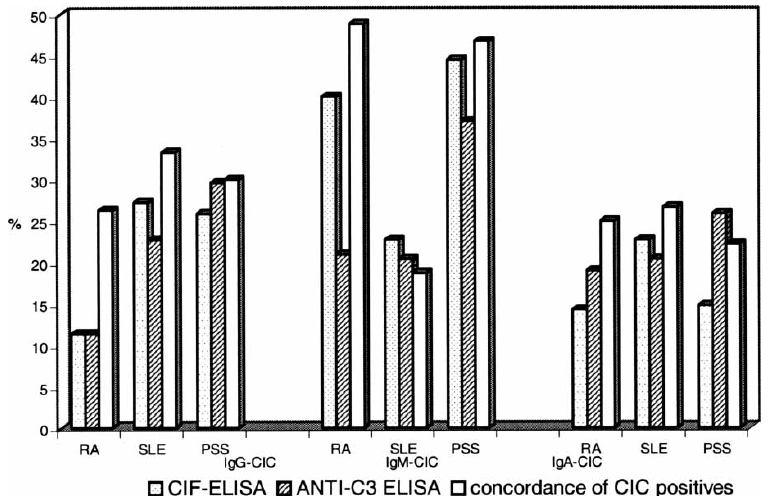
FIGURE 2 The Relative sensitivity and Concordance of IgG-CIC, IgM-CIC and IgA-CIC positive sera in patient groups detected by CIF-ELISA and ANTI-C3 ELISA. Relative sensitivity is calculated as percent (%) of positive sera. Concordance is calculated by the formula: the number of double positives as a percentage of the total number of single and double positive